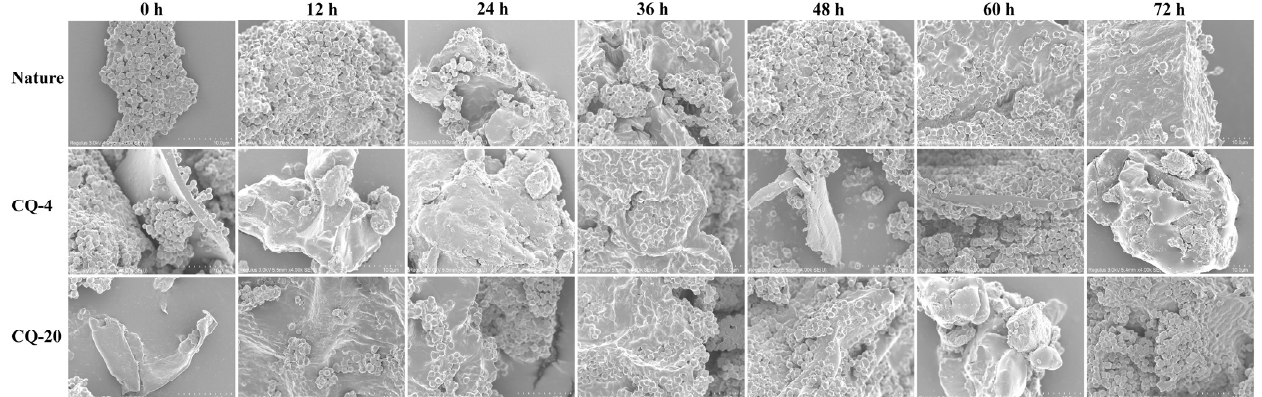
Figure 6. The scanning electron microscopy (SEM) of native and fermented quinoa flour under cold stress at 4 °C and − 20 °C. Native: native quinoa flour; CQ − 4: quinoa flour cold stress treated at 4 °C; stress at 4 ◦ C and − 20 ◦ C. Native: native quinoa flour; CQ − 4: quinoa flour cold stress treated at 4 ◦ C; CQ − 20: quinoa flour cold stress treated at − 20 °C. The letter A − U represents different samples. CQ − 20: quinoa flour cold stress treated at − 20 ◦ C. The letter A − U represents different